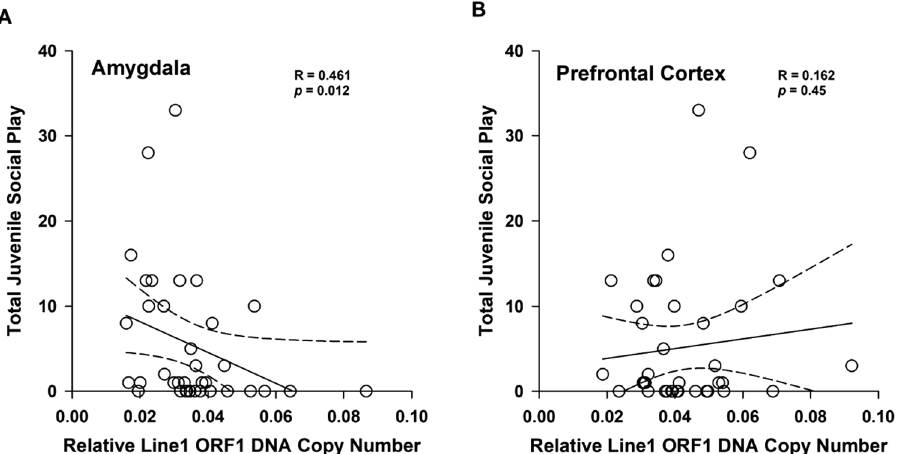
Figure 4. ( A ) Juvenile social play levels correlate with relative Line1 Orf1 DNA copy number in the amygdala. ( B ) Juvenile social play levels are not correlated with relative Line1 Orf1 DNA copy number in the prefrontal